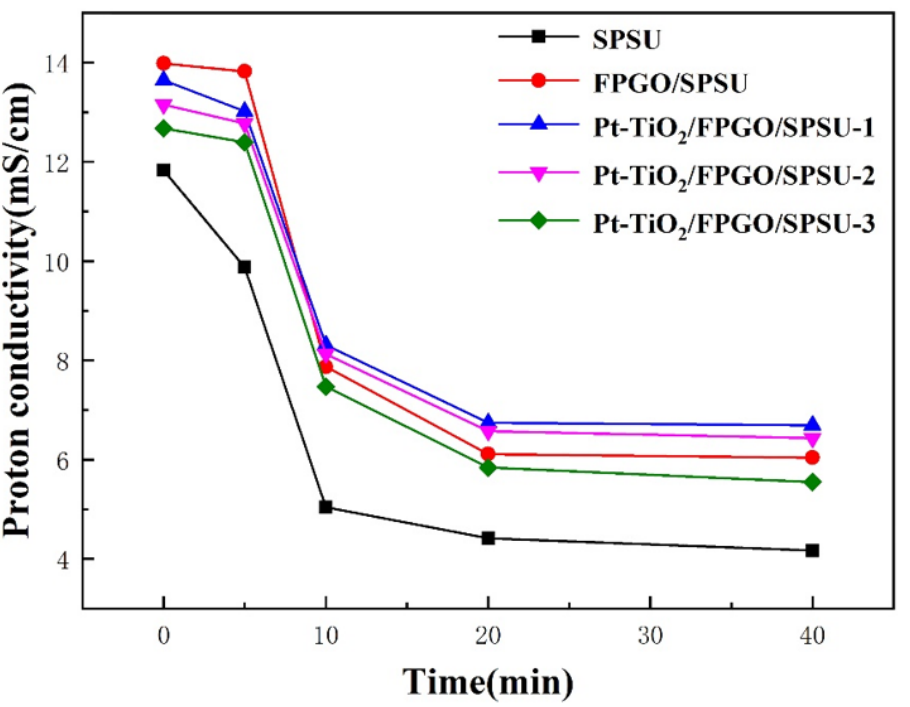
Figure 9. Proton conductivity of all the membranes at a constant temperature of 60 °C with time.